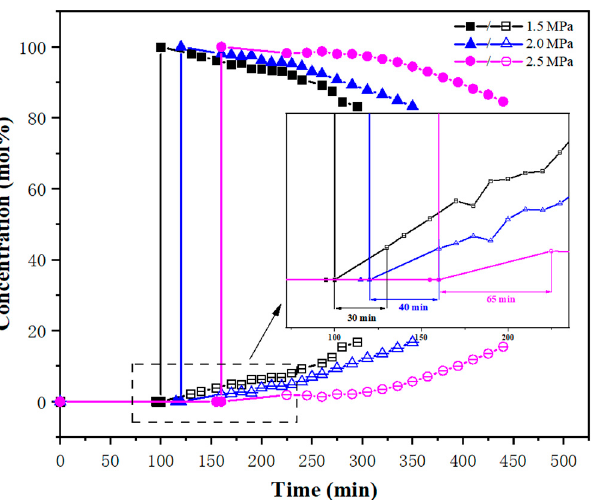
Figure 5. Breakthrough experimental results of a CH 4 /H 2 (34.22/65.78 mol%) mixture separation in a slurry of ZIF-8 20 wt% + ethylene glycol 16 wt% + water 64 wt% at the inlet gas flow rate of 27.72 mL/min, as well as conditions: 273.15 K, different pressures of 1.5 MPa, 2.0 MPa, and 2.5 MPa. (The solid curve in the figure is H 2 and the hollow curve is CH 4 ).